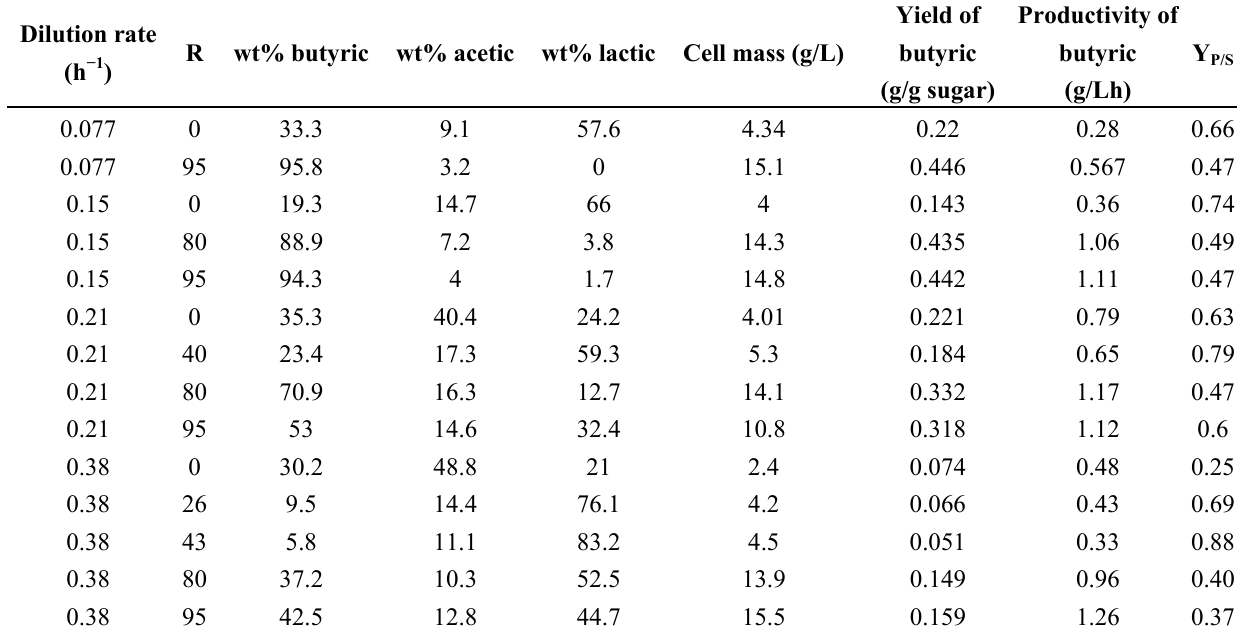
Table 3. Comparison of continuous fermentation with C.